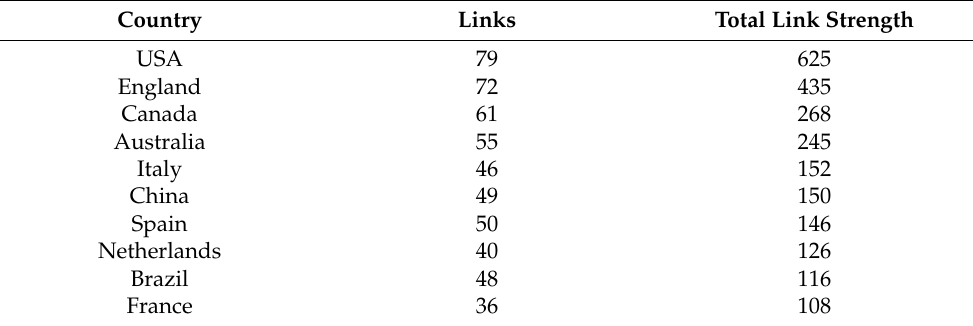
Table 3. The countries cooperation network ranked by total link strength.